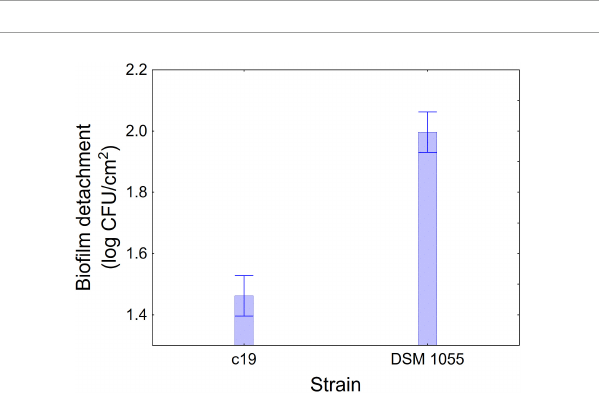
FIGURE2 Decomposition of statistical hypothesis related to the individual term of strain on the detachment of biofilm (log CFU/cm 2 ) of L. plantarum c19 and DSM 1055. Mean values ± 95% confidence interval.